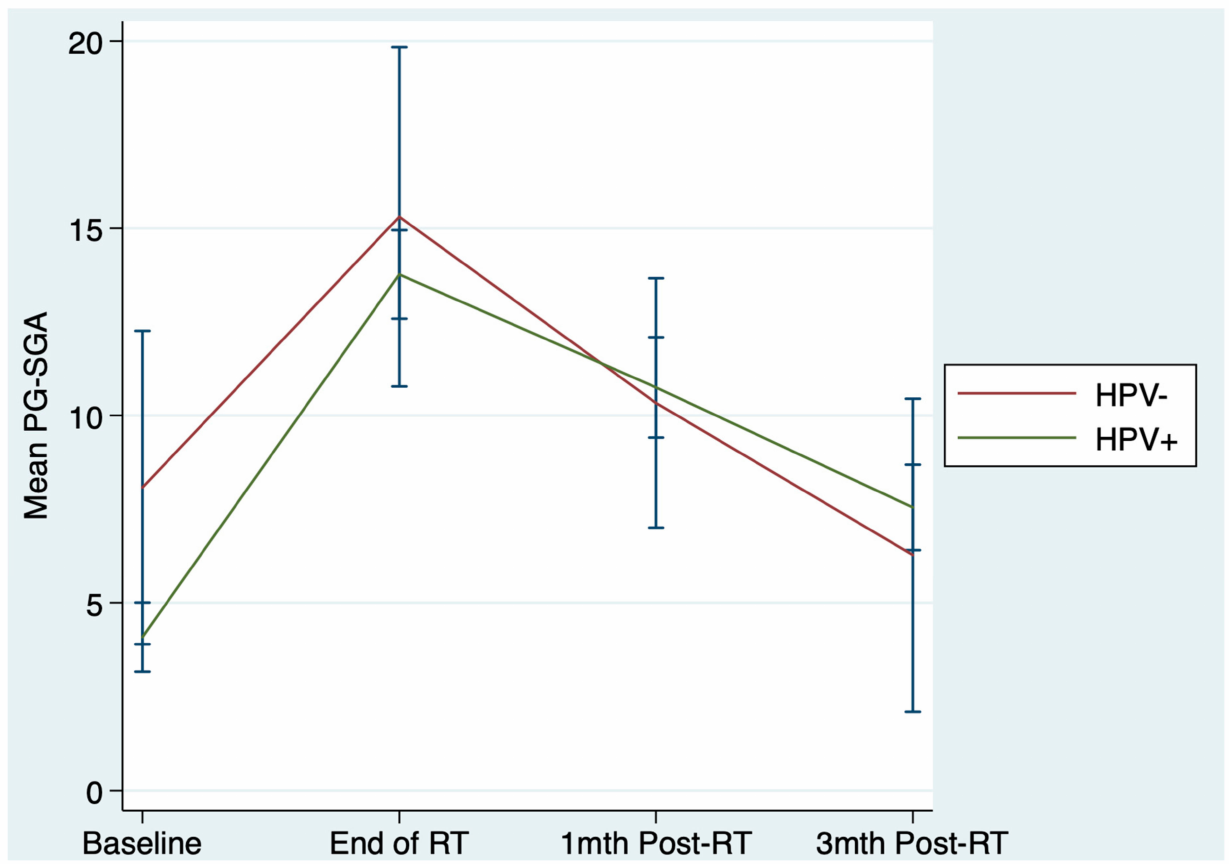
Figure 1. Mean PG-SGA (Patient Generated-Subjective Global Assessment) score by HPV (Human papillomavirus) status over all timepoints with 95% Confidence